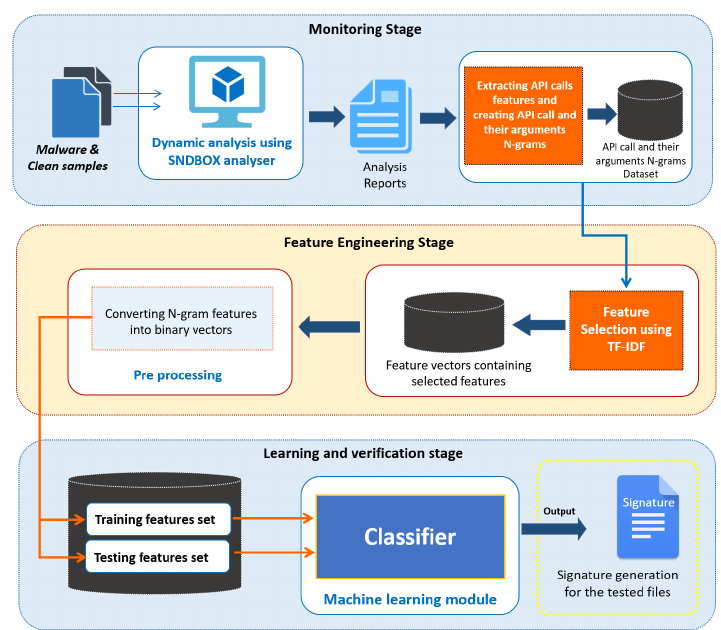
Figure 3. Flow diagram of proposed scheme.